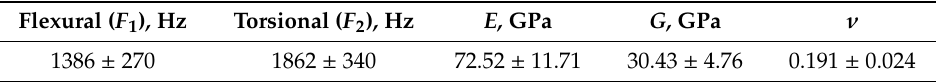
Figure 6. IET time series analysis ( a ) and power spectrum analysis ( b ) results. Table 3. Test results of E, G and ν in IET.